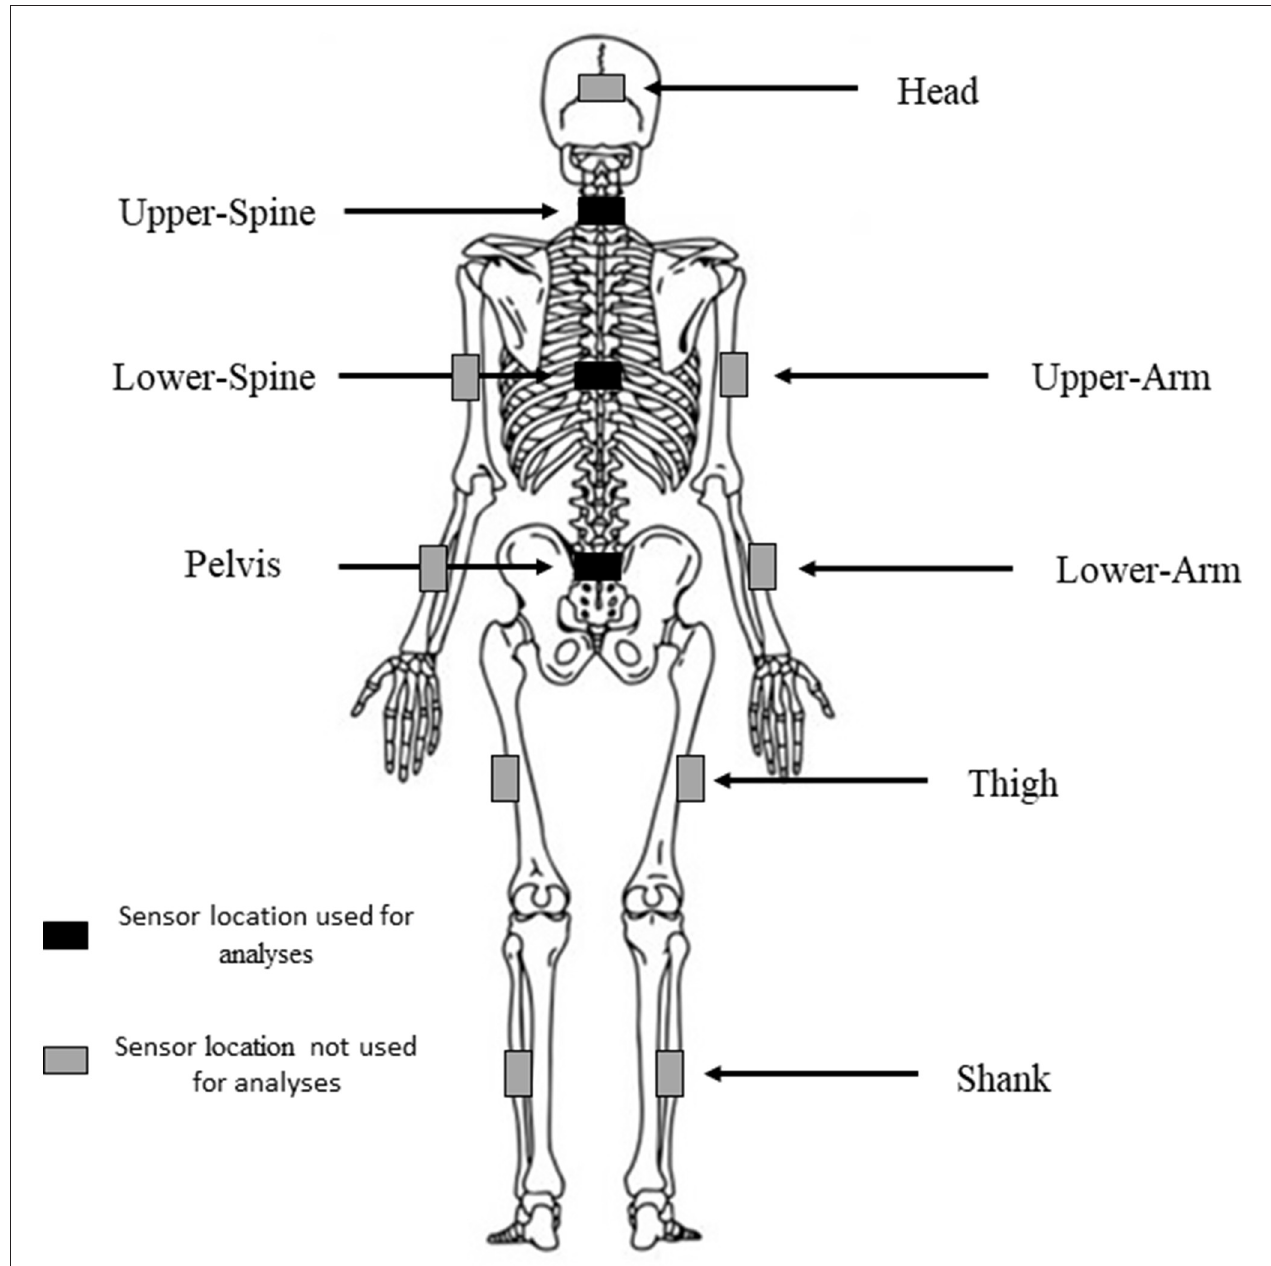
FIGURE 1 | Depiction of the IMU sensor locations during the XC skiing time-trials.